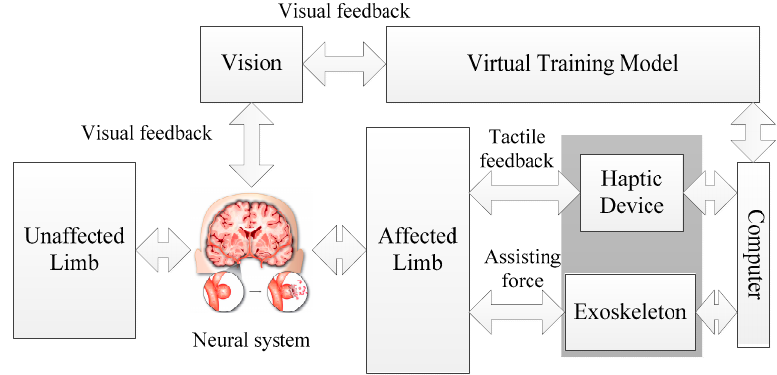
Figure 1. Neuro-training with the proposed system.